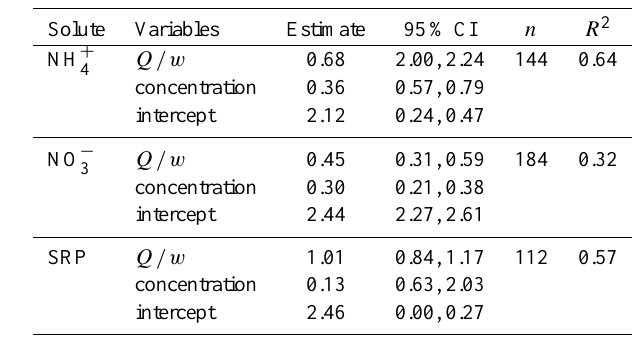
Table 2. Parameter estimates and statistics from multiple linear re- gression of log 10 solute uptake length ( m ) vs. log 10 specific dis- charge ( Q/w) , log 10 solute concentration. Confidence intervals (CI) are t -based CI from regression standard error. Number of cases is n and goodness of fit is R 2 . p values for all parameters are <0.00001 except for SRP concentration, which has p =0.054. Be- cause of different line-fitting methods, parameters for multiple lin- ear regression are not the same as for standardized major axis re- gression.